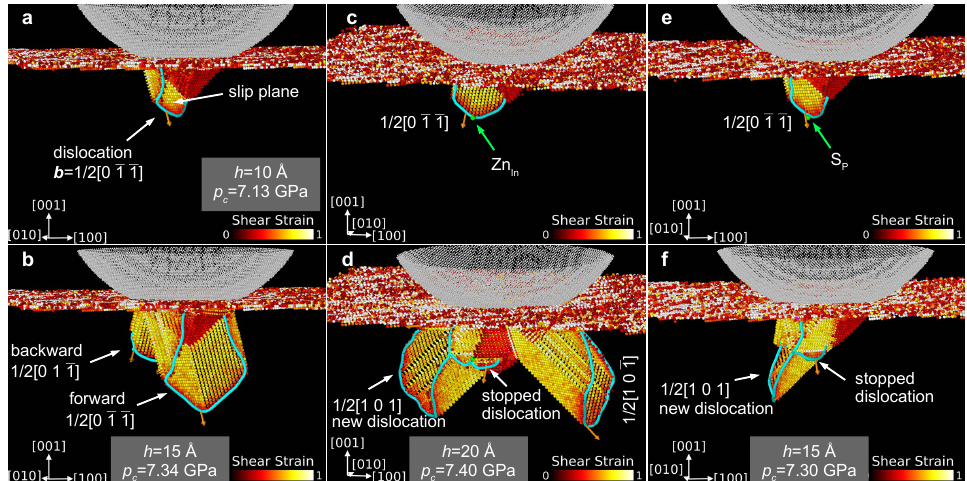
Figure 3. Example results of MD simulations showing the effect of point defects on the development of dislocations during nanoindentation of the InP (001) surface. ( a , b ) Undoped InP: as indentation proceeds, the initial dislocation with the Burger vector b = 1/2 [ 0¯1¯1 ] develops and another dislocation (backward, b = 1/2 [ 01¯1 ] ) is generated. ( c , d ) Zn-doped InP: the presence of Zn atom in front of the initial dislocation ( b = 1/2 [ 0¯1¯1 ] ) stops its growth (well visible bending, pinning effect) and a new dislocations ( b = 1/2 [ 101 ] , b = 1/2 [ 10¯1 ] ) appear in the crystal. ( e , f ) S-doped InP: the presence of S atom acts in similar way, as in the case of Zn-doping. As a result, the development of existing dislocations is stopped. The increasing load can be accommodated by the emergence of new defects. The symbols h and p c denote the indentation depth and the instantaneous contact pressure value,